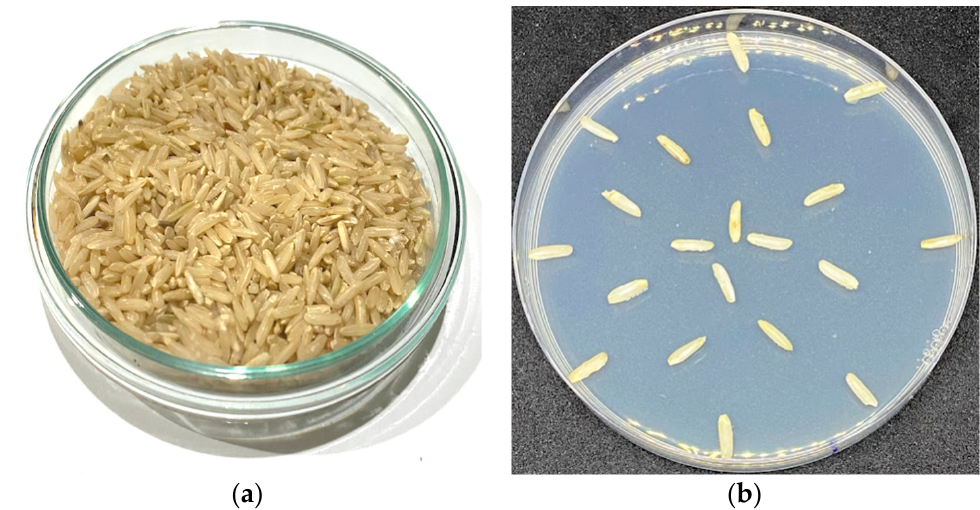
Figure 4. Samples for investigating fungal inactivation: ( a ) rice sample; ( b ) rice grains on PDA before incubation.